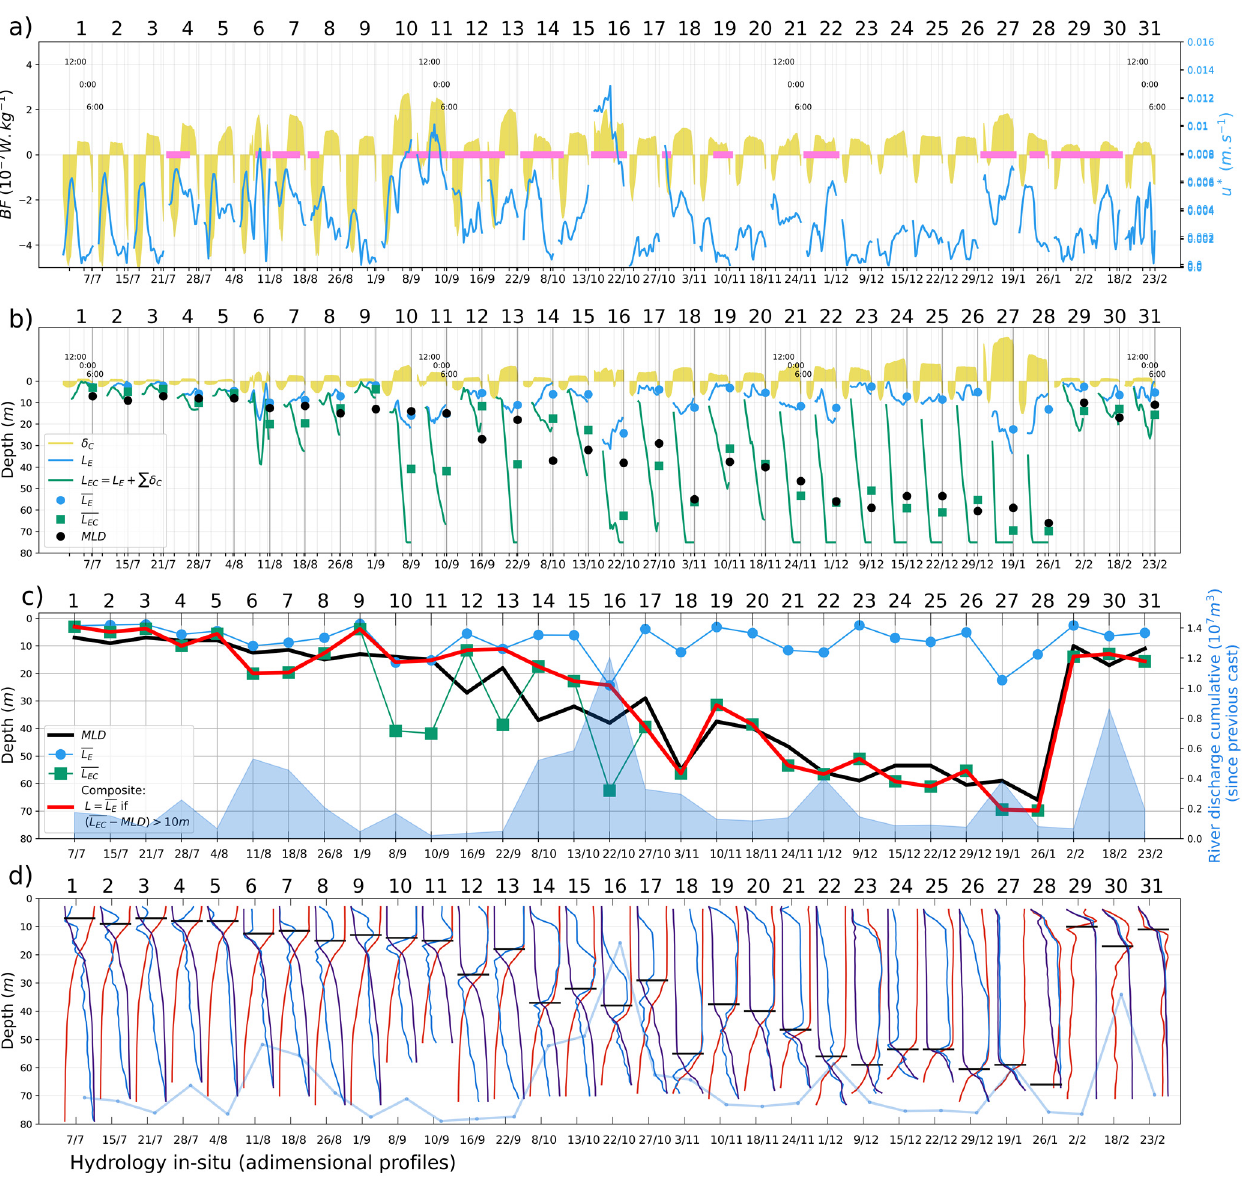
Figure 4. ( a ) Time series of wind stress (blue) and buoyancy fluxes (yellow) during the 24 h before each cast. Critical periods when La < 0.5 are indicated in pink. ( b ) Ekman layer L E (blue), convective variation δ C (yellow), and their combination L EC (green) to compare to the observed MLD (black dots). Blue dots and green squares: L E and L EC averaged for 18 h before the cast. ( c ) Time course of the MLD (black), compared to L E (blue) and L EC (green). On the right y-axis, we show the cumulative of the Sarno’s river discharge since the last cast. ( d ) Adimensionalized vertical profiles of T , S , σ (respectively, in red, blue, and dark purple). Black horizontal lines: MLD estimates; blue transparent in the background: cumulation of the Sarno’s river discharge between the casts reproduced without units from ( c ).